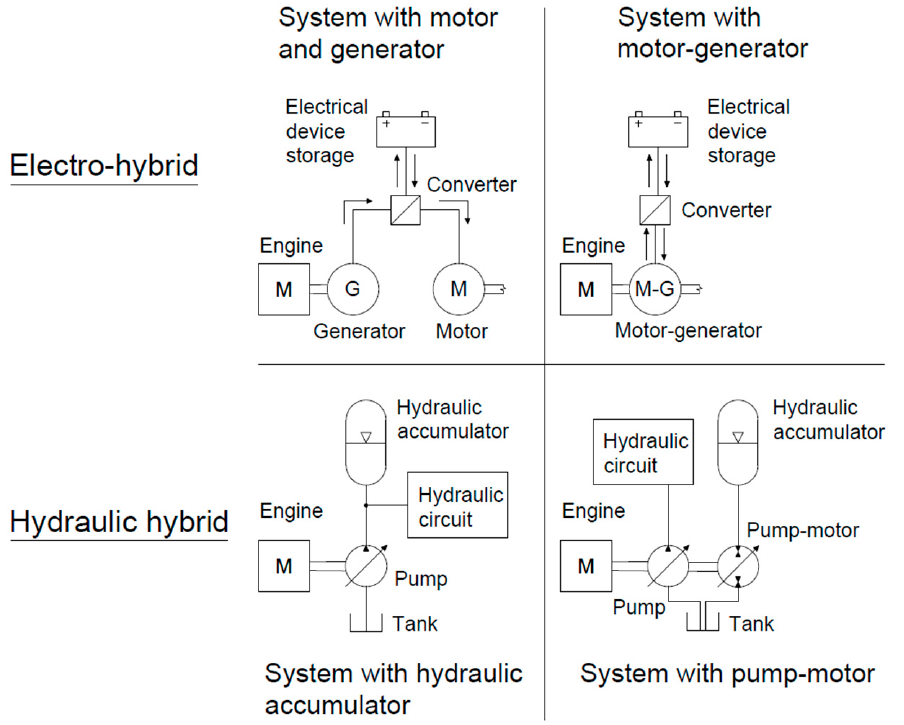
Figure 1. Hybrid systems in forestry and their components (author: Václav Mergl).